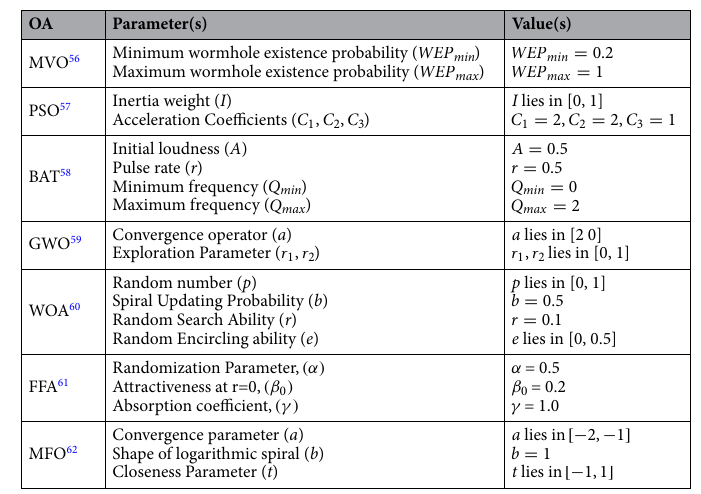
Table 4. Parameter settings for the comparative meta-heuristic optimization algorithms. OA denotes Optimization Algorithms.